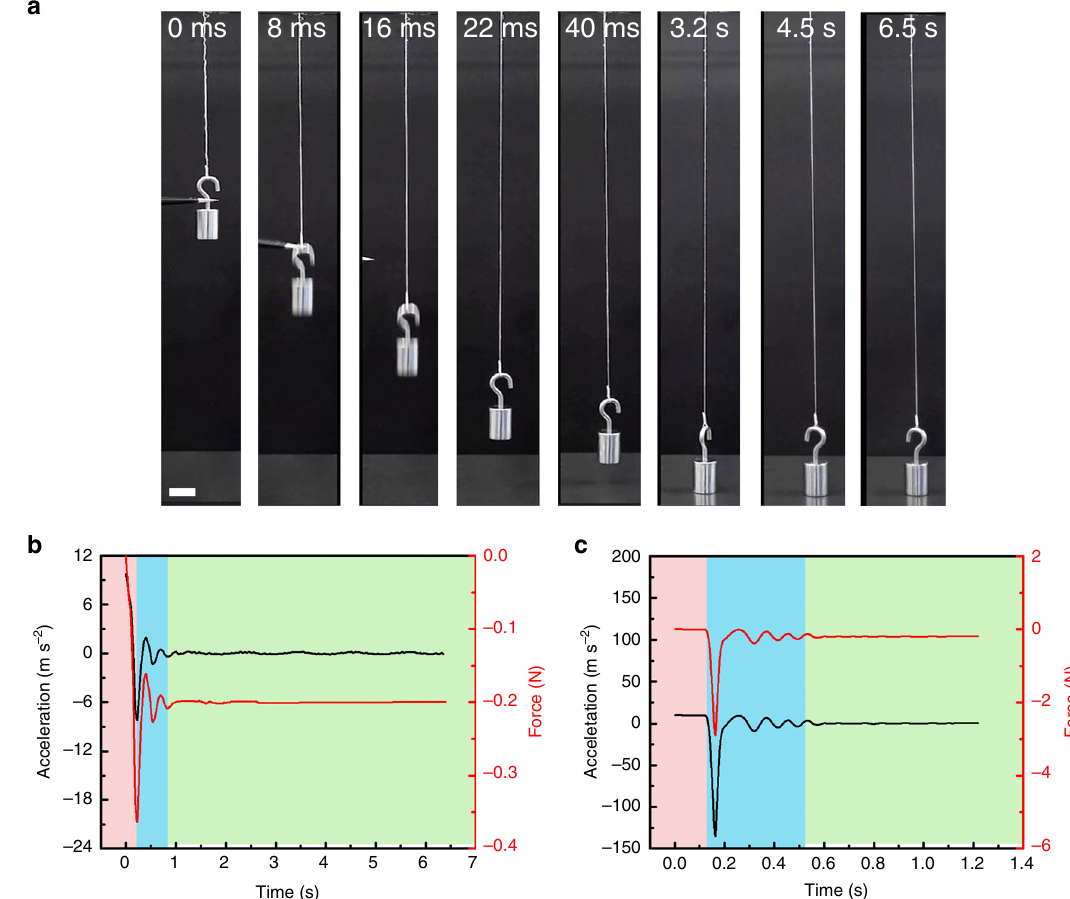
Fig. 4 Impact reduction ability of hydrogel yarns. a Snapshots of a free falling 20-g object connected to a hydrogel yarn. The falling height was 15 cm. Scale bar: 2 cm. b, c Acceleration and impact force of the object buffered by ( b ) a hydrogel yarn and ( c ) a cotton yarn as a function of time. The hydrogel yarns were made of 100-plied, 10-cm-long, 20- μ m-diameter hydrogel fi bres and the hydrogel fi bre contained 0.1 wt% VSNPs and 20 mM ZnCl 2 with an inserted twist of 3 turns mm − 1 . The cotton yarn was 200 μ m in diameter and 25 cm in